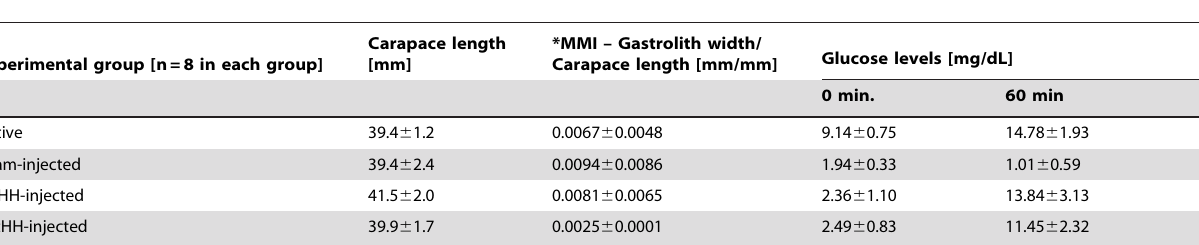
Table 1. Morphometric characteristics of the experimental females, their hemolymphatic glucose levels before injection and at their